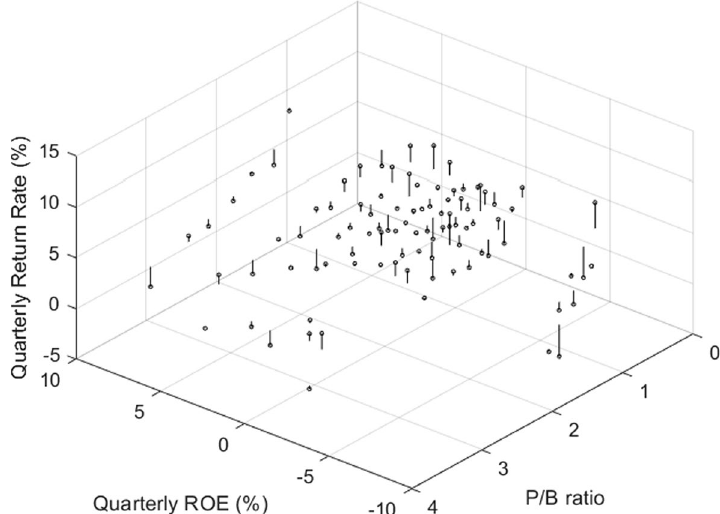
Fig. 41 3D scatter diagram of ROE (X), P/B (Y) in the t quarter, and return rate in the t actual values, another end: predicted values): Modified